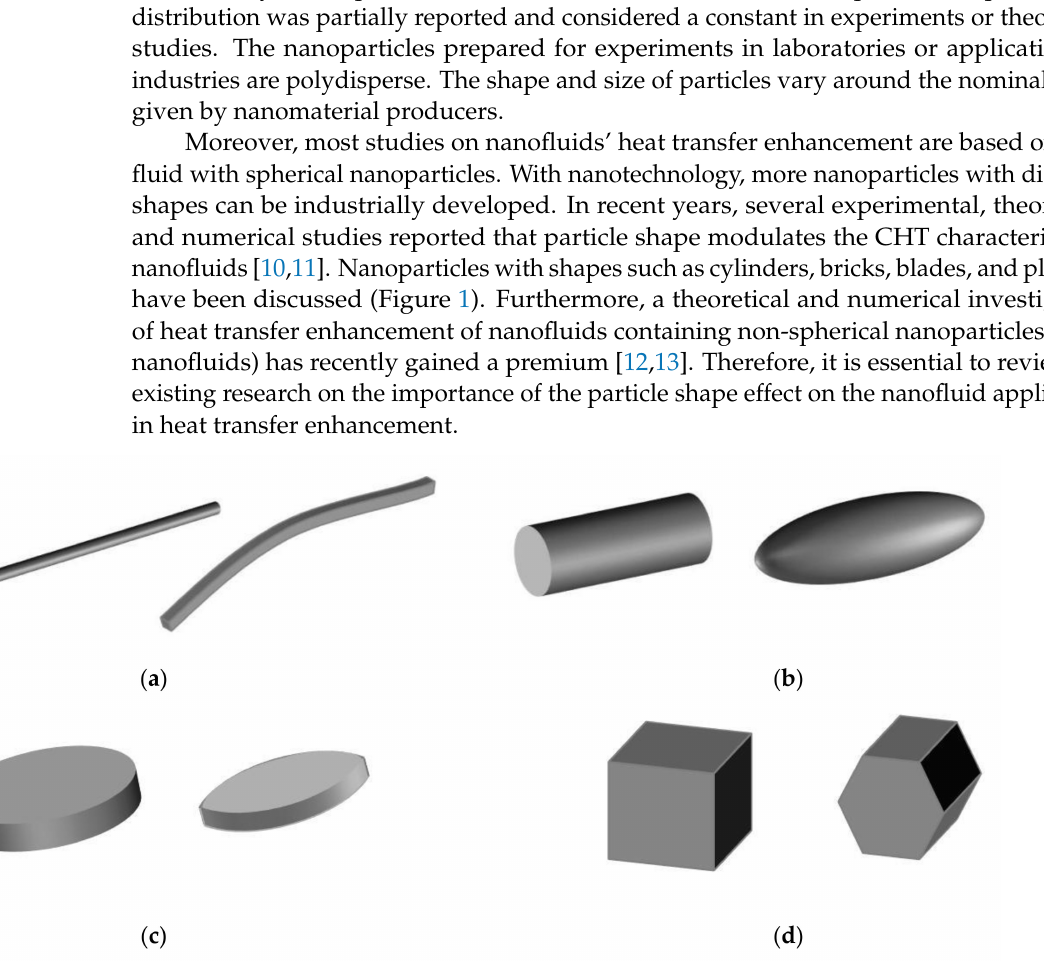
Figure 1. Shapes of non-spherical nanoparticles used in nanofluids. ( a ) CNTs/nanofibers/nanowires; ( b ) rods/cylinder/ellipsoids; ( c ) platelets/blades; ( d )